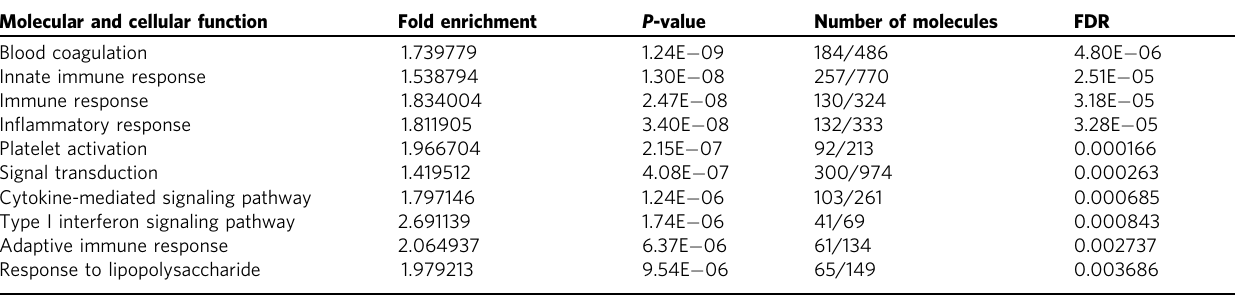
Table 1 Gene expression pro fi ling of MNCs in the presence or absence of PMP treatment. Molecular and cellular